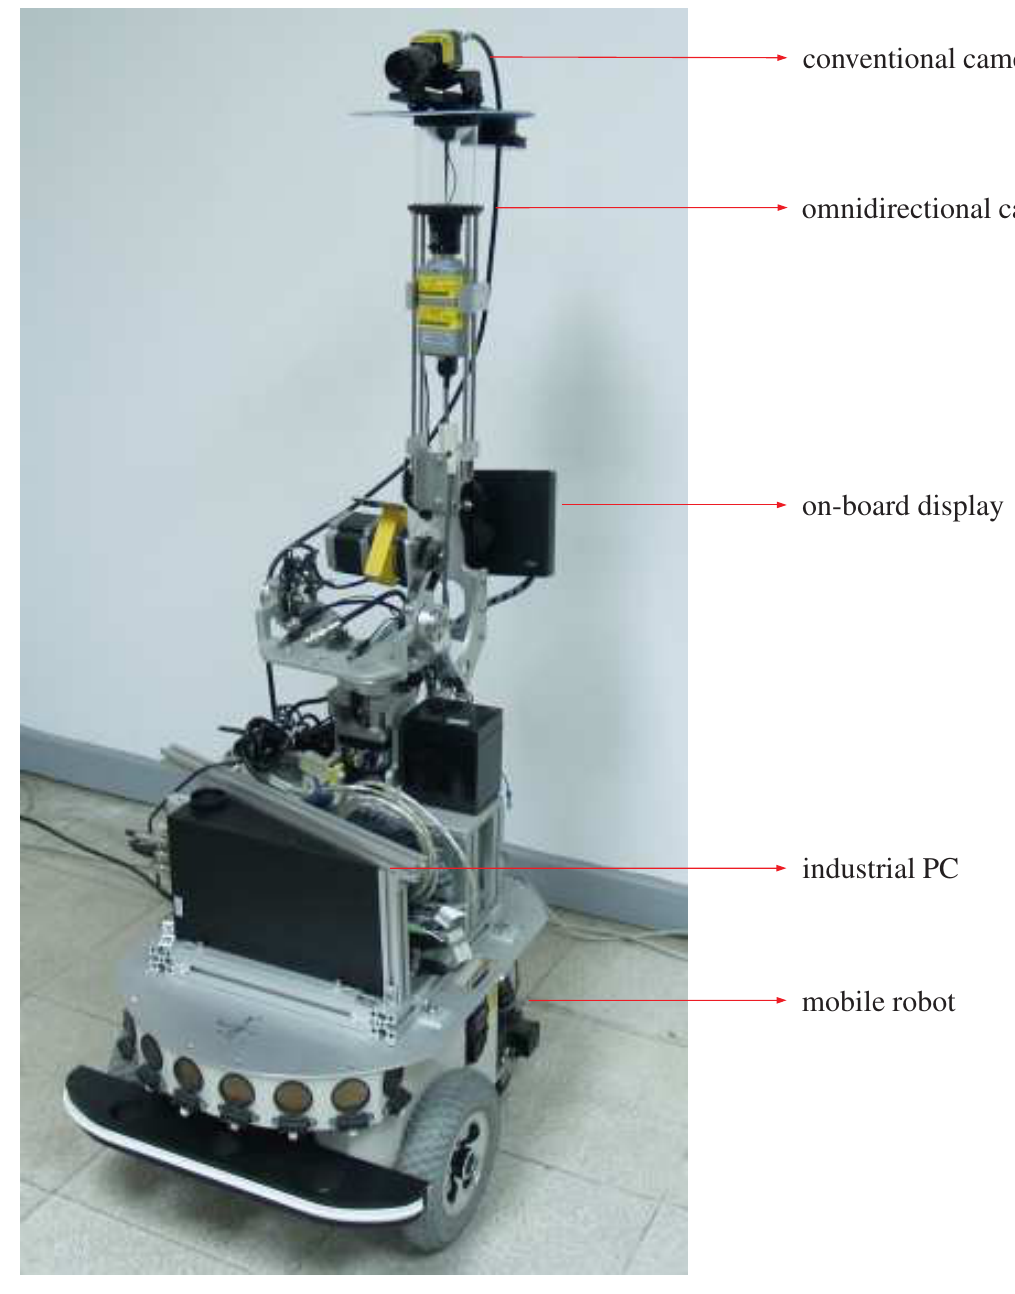
Figure 5. The mobile robot platform and HOPIS used in the real scene experiments. The conventional camera is capable of changing the viewpoint through the motor controlled pan-tilt